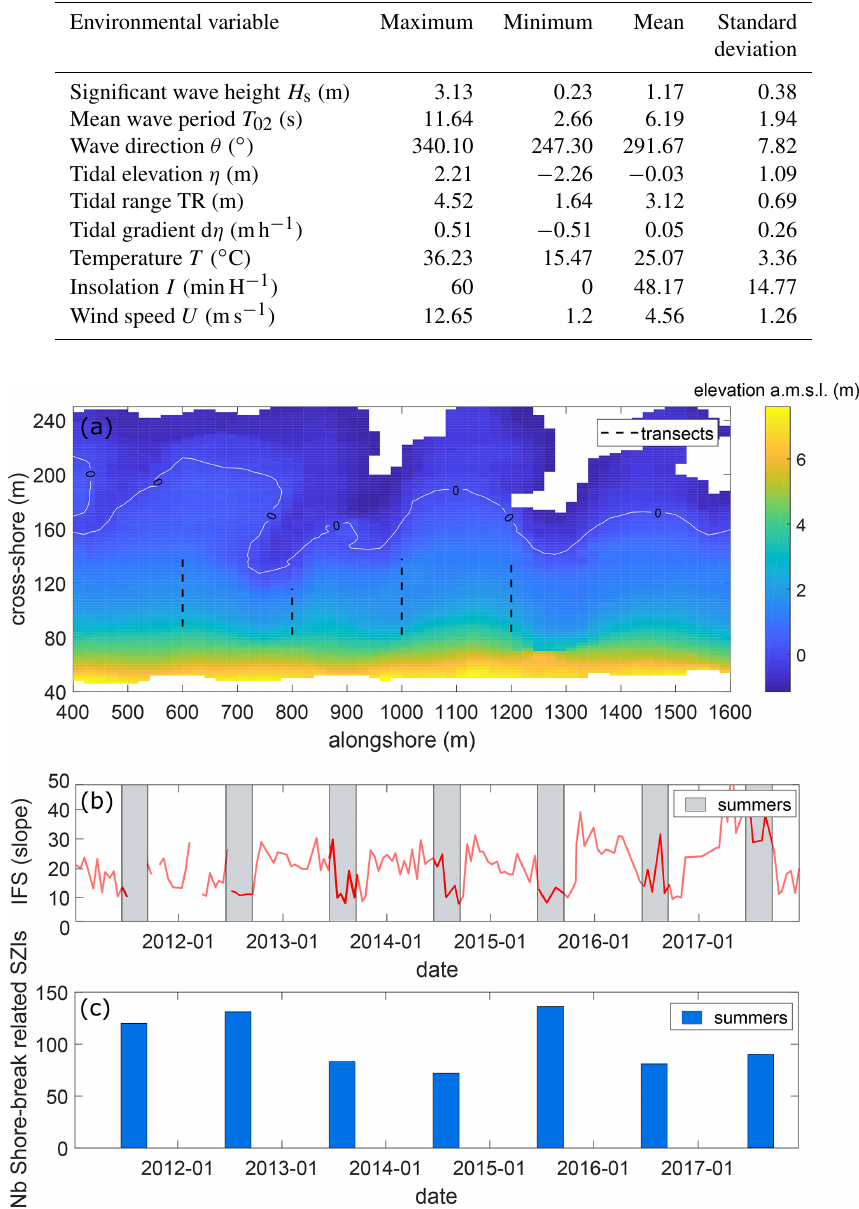
Figure 3. (a) Example of a digital elevation model of Truc Vert beach on 29 April 2013, with the colour bar showing elevation above mean sea level. The four cross-shore transects used to compute the inverse beach slope IFS between 1 and 3ma.m.s.l. are indicated by the dashed black lines. (b) Time series of IFS and (c) summer shore-break-related